Question: Provide a publication-style caption for this figure.
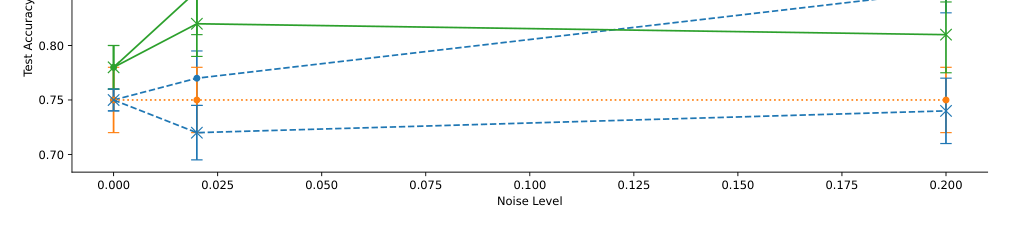
Answer: Accuracy on the arithmetic task against noise level (frequency with which noise tokens are added), for ground-truth noise consisting of digits and random noise consisting of random tokens. The ground-truth noise improves accuracy for the behavioral cloning and SequenceMatch models. The random noise does not improve performance for the behavioral cloning model, but does some- what for the SequenceMatch model, likely helping the model to learn the dynamics of <bkspc>.